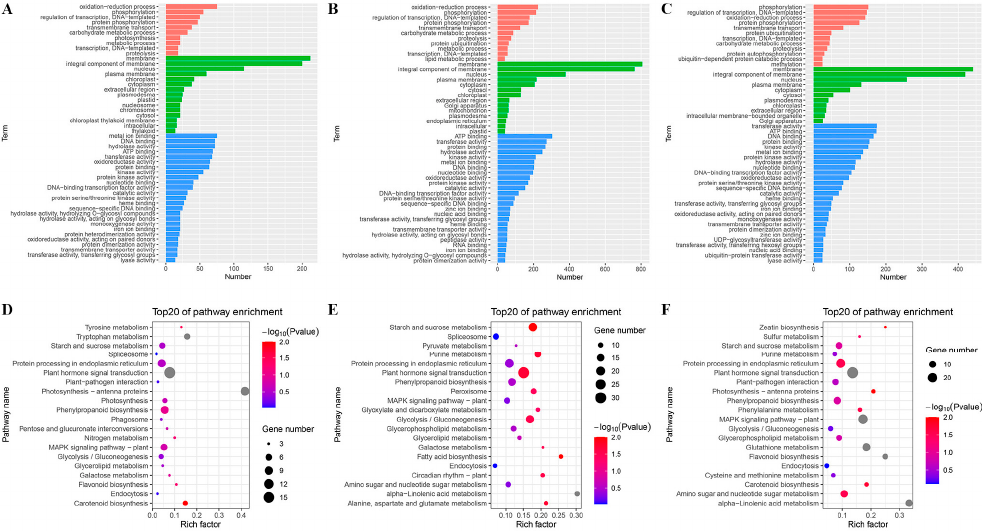
Figure 5. GO function and enrichment pathway analysis of differential genes in different material comparison groups. (A) GO analysis of differential genes in the B73-CK vs. rpn10 -CK comparison group; (B) GO analysis of differential genes in the B73-CK vs. B73-BR comparison group; (C) GO analysis of differential genes in the rpn10 -CK vs. rpn10 -BR comparison group (Red indicates biological process; green indicates cellular component; blue indicates molecular function); (D) significant pathway enrichment analysis of B73-CK vs. rpn10 -CK comparison group; (E) significant pathway enrichment analysis in the B73-CK vs. B73-BR comparison group; (F) significant pathway enrichment analysis in the rpn10 -CK vs. rpn10 -BR comparison group.